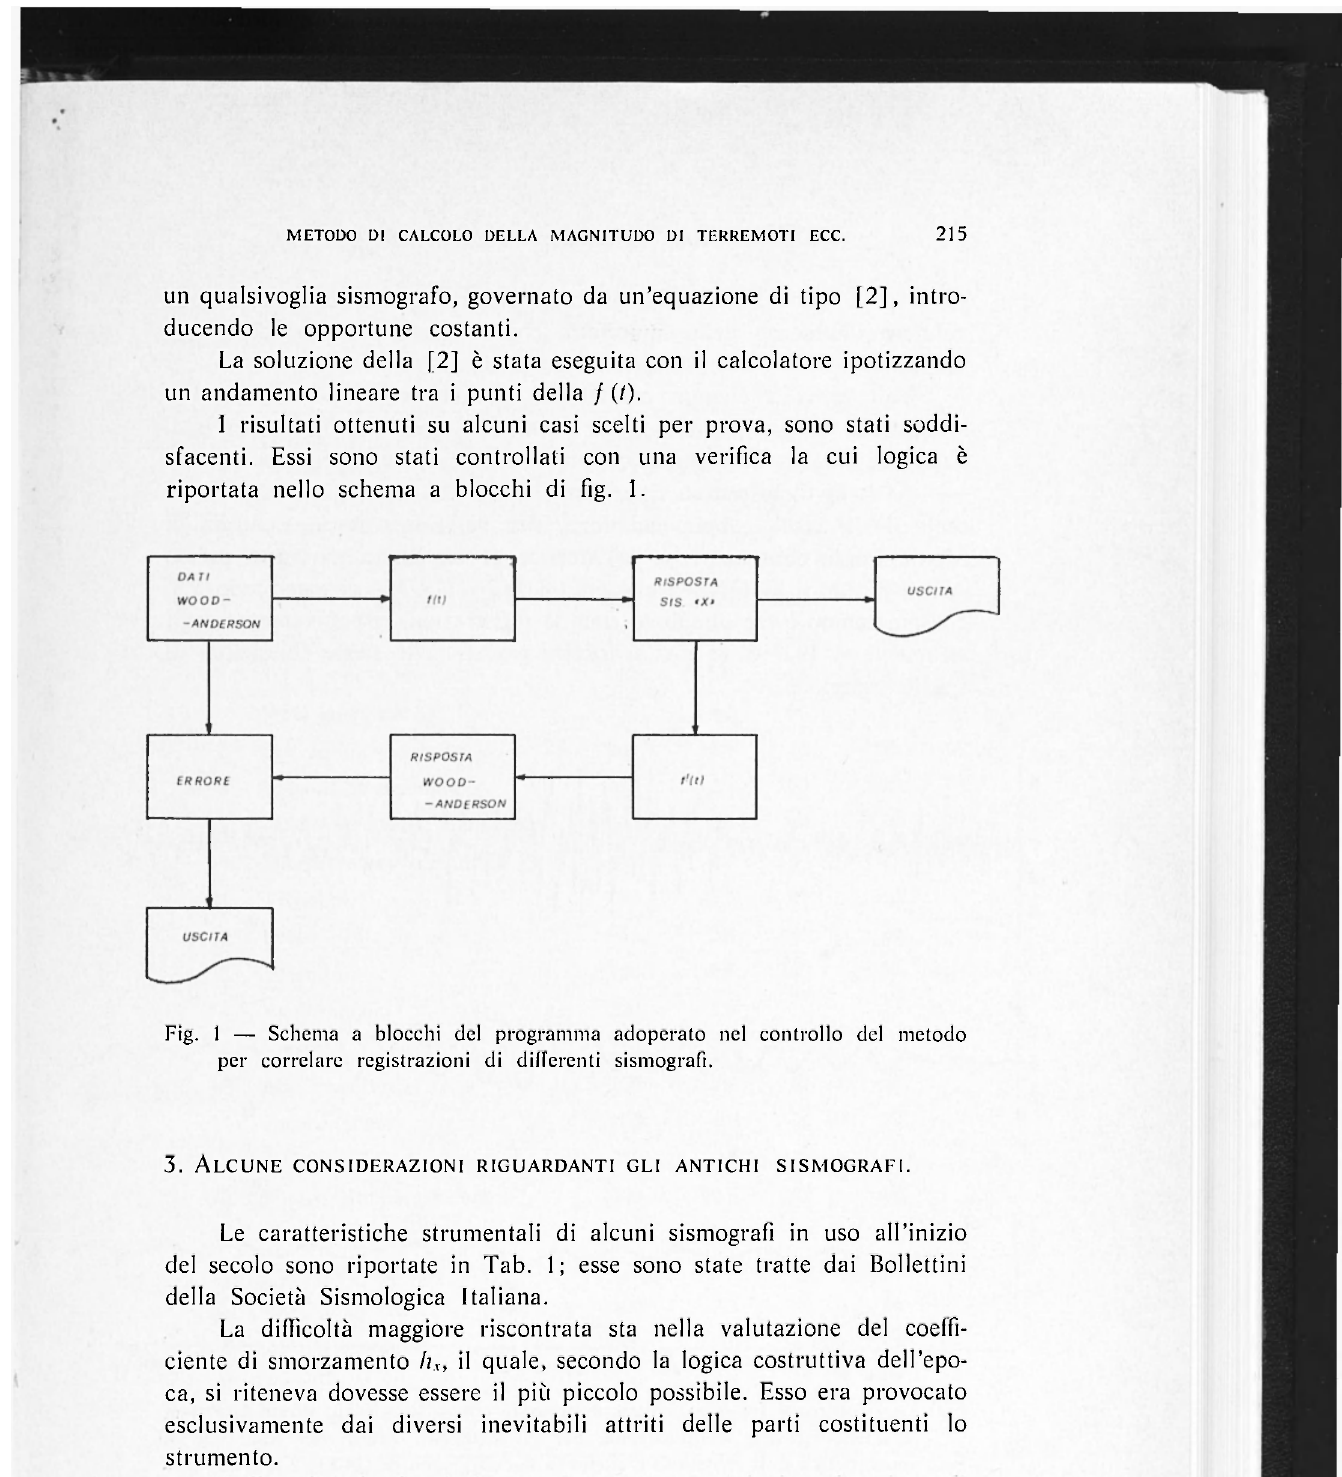
Fig. 1 — Schema a blocchi del programma adoperato nel controllo del metodo per correlare registrazioni di differenti